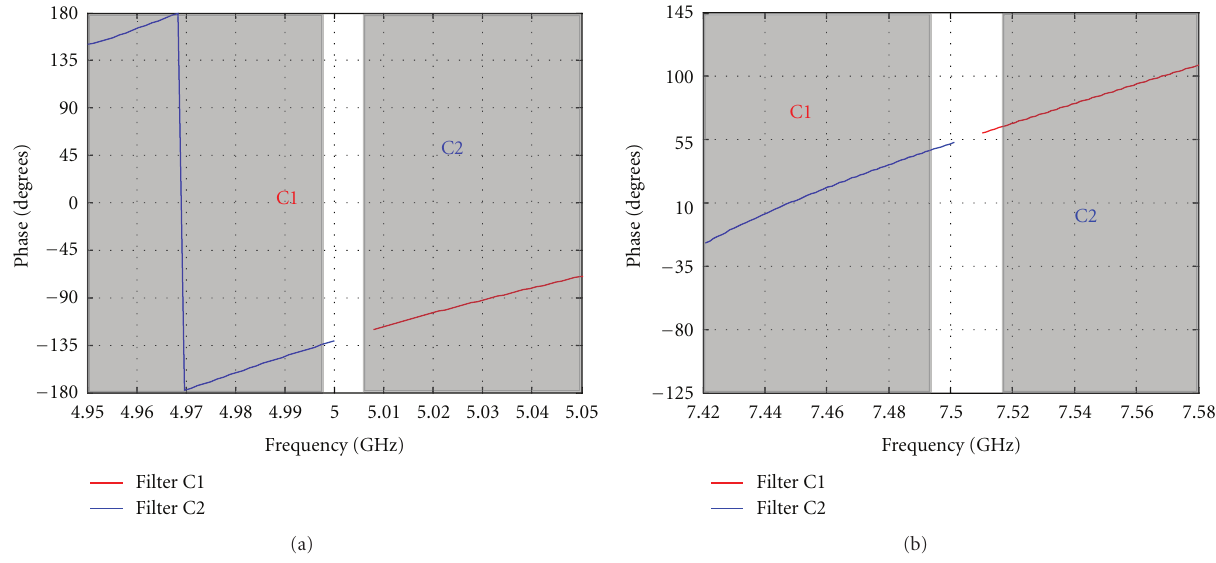
Figure 13: S22 ideal phase profile for each filter outside its operating band at f L (a) and f H (b).